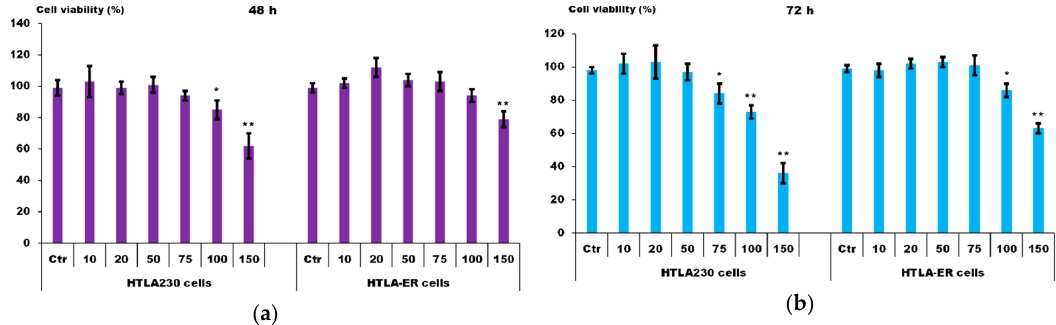
Figure 11. Time course of viability (%) of HTLA-230 and HTLA-ER cells treated with GA. The analysis was performed by CellTiter 96 ® Aqueous One Solution Cell Proliferation Assay in HTLA-230 and HTLA-ER cells exposed to GA (10–150 µM) for: 48 h ( a ); and 72 h ( b ). Histograms summarize quantitative data of the means ± S.E.M. of three independent experiments. ** p < 0.01 vs. Ctr cells; * p < 0.05 vs. Ctr cells.